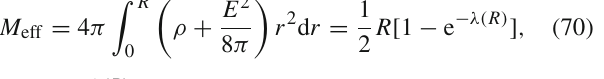
Fig. 14 Plot for mass-to-radius ratio M / R with respect to radius R for RX J